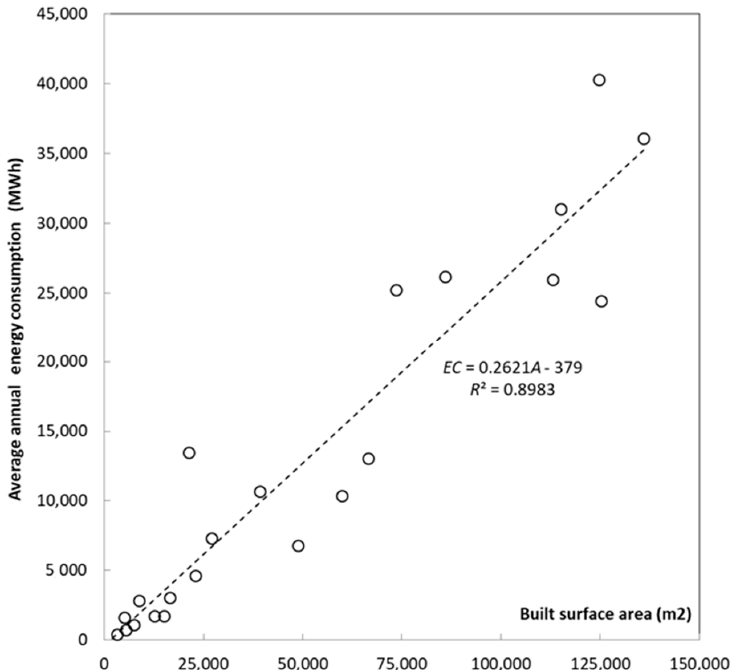
Figure 3. The relationship between the average annual energy consumption and the built area per hospital.